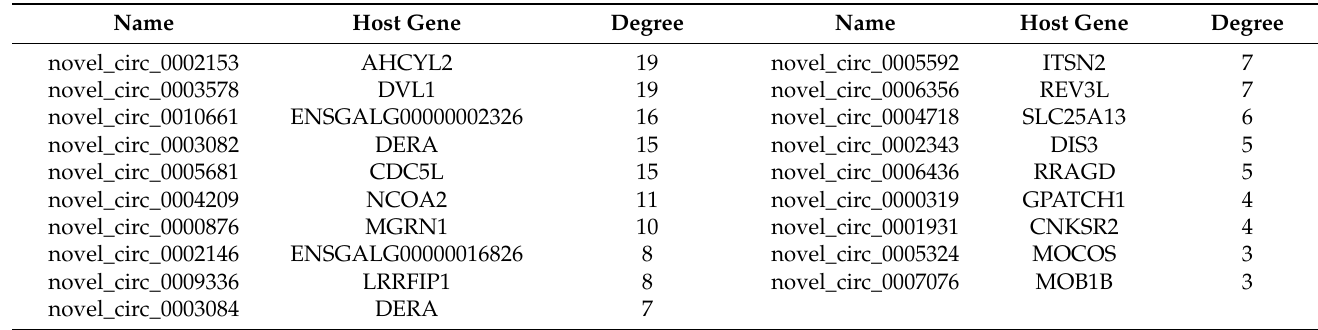
Figure 5. circRNA–miRNA interaction network. Note: Circular nodes represent circRNAs, and the triangle nodes represent miRNAs. The degrees of red nodes are high, while the degrees of blue nodes are low. Table 1. 19 Co-differentially expressed circRNAs with their